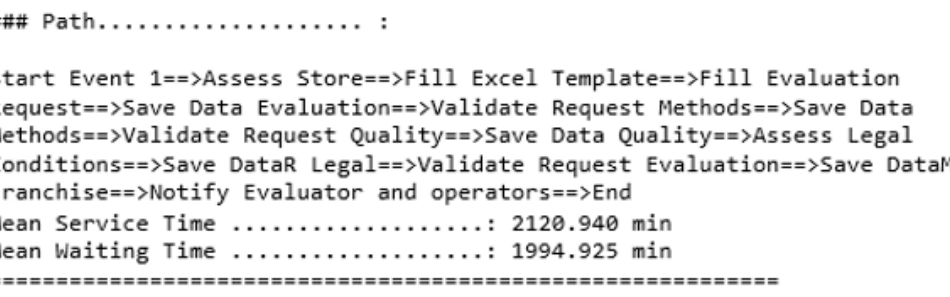
Figure 23. Global results after user interface improvements.